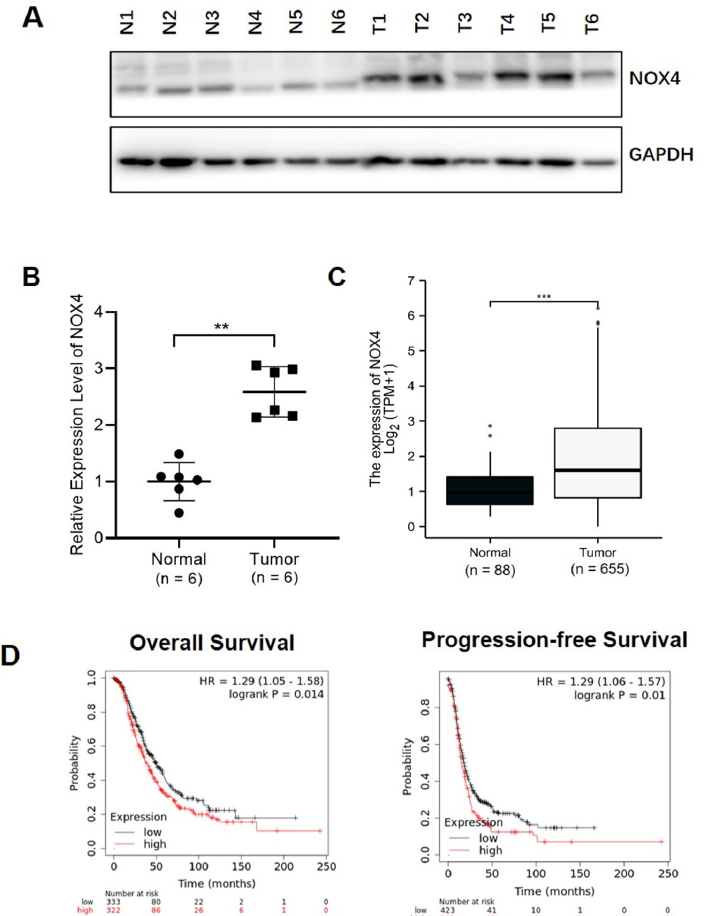
Figure 1. High NOX4 levels were correlated with ovarian cancer development. ( A ) The expression levels of NOX4 in tumor tissues of human ovarian cancer patients (N1–N6) and the normal control samples (T1–T6). ( B ) The mRNA expression levels of NOX4 in ovarian cancer tissues and normal tissues obtained from the TCGA database. ( C – D ) The correlation between NOX4 expression levels and overall survival (OS) or progression-free survival (PFS) in ovarian cancer patients in the TCGA database. ** Indicates significant difference at p < 0.01, *** Indicates significant difference at p <